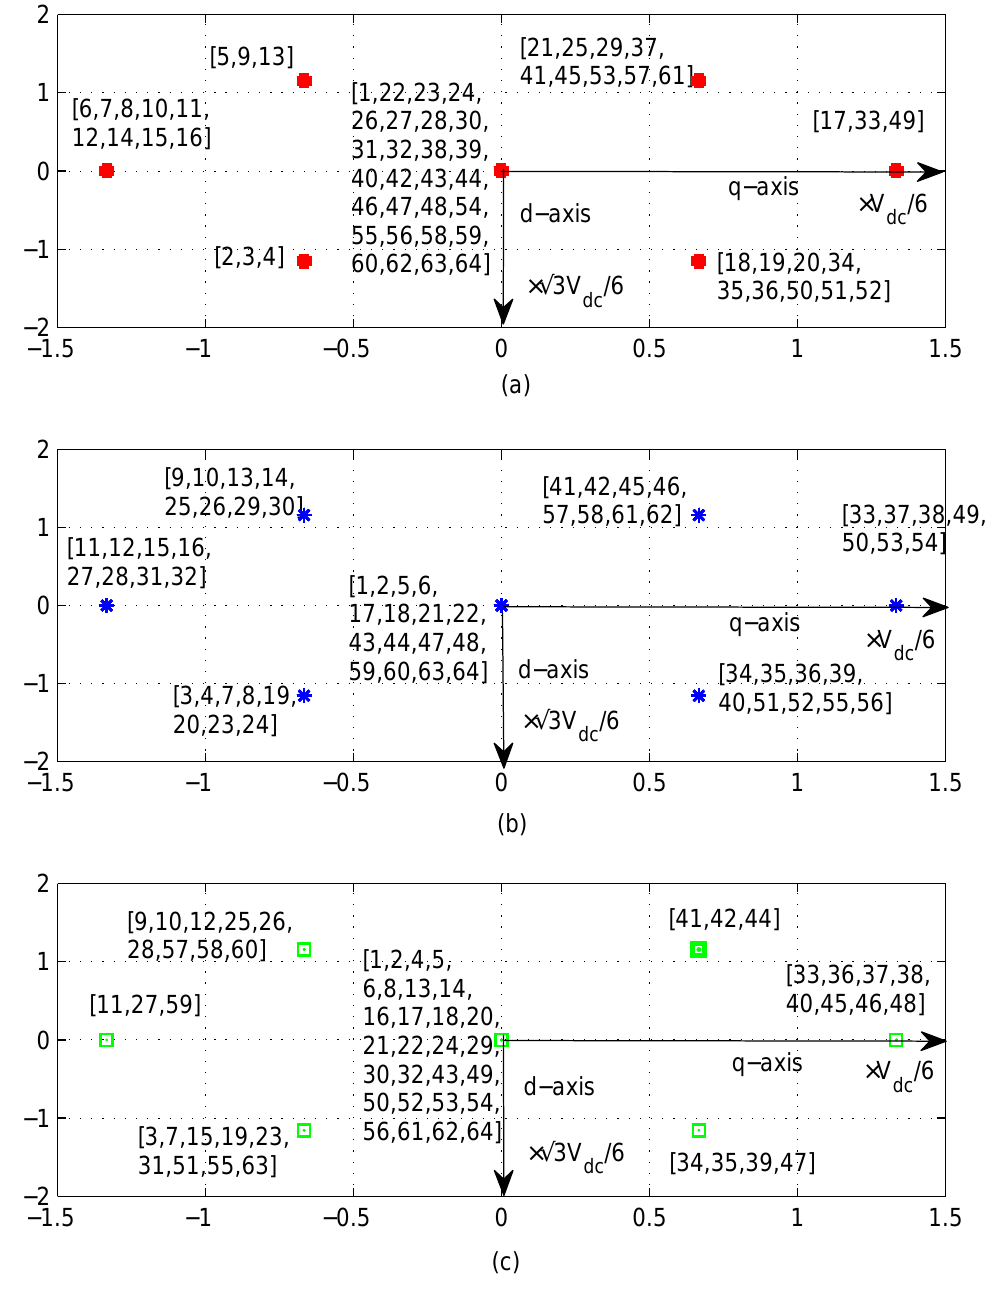
Figure 2: 12 -switch converter space vector diagram for (a) Inv 1 , (b) Inv 2 , and (c) Inv 3